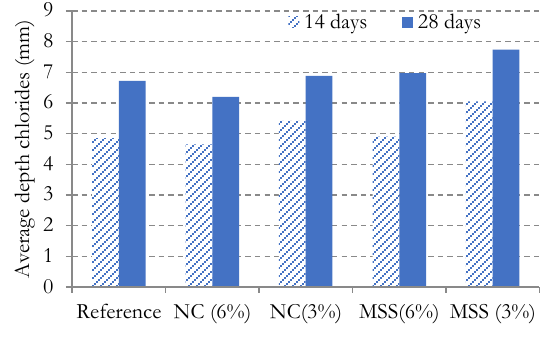
Figure 3. Carbonation depth and chlorides (mm) ( a )Carbonation ( b )Chlorides.